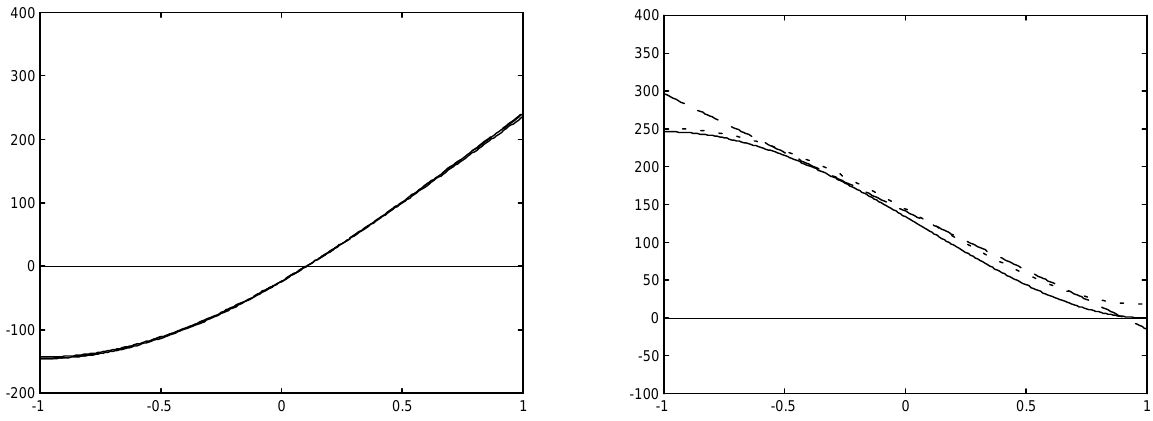
Fig. 6. Mode 1 deflected form (LHS) and curvature (RHS) for a Free-Free Beam. LDV scan between the centre and the tip: Theoretical (full line), Initial measurement (dashes), Final iteration (dotted). + V x n y m sin( ωt + α ) } bn,m n Real and imaginary ODS polynomial coefficients for V an,m V bn,m the deflection w ( x, y, t ) , are and − ω ω